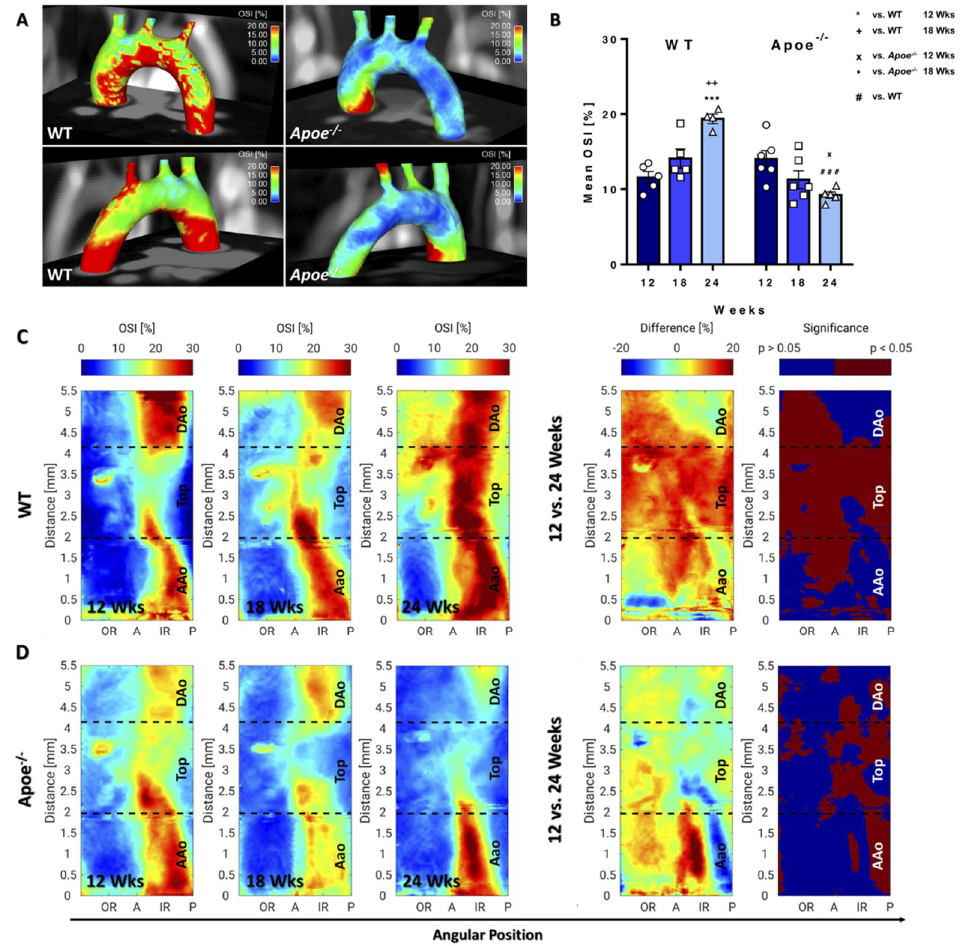
Figure 6. OSI decreases in Apoe − / − mice during atherosclerosis progression but increases in WT mice during ageing. ( A ) Three-dimensional OSI map of a 24-week-old WT mouse (left) and Apoe − / − mouse (right) from anterior and posterior view. The WT mouse showed high OSI values throughout the IR of the complete aorta, whereas in the Apoe − / − mouse, values were only elevated in the IR of the AAo (see red spot). ( B ) Mean OSI: Values significantly increased in WT and decreased in Apoe − / − mice. *** vs. WT 12 weeks, p < 0.001; ++ vs. WT 18 weeks, p < 0.01; x vs. Apoe − / − 12 weeks, p < 0.05; ### vs. WT, p < 0.001. ( C ) OSI maps of WT mice (group average) for all measurement time points and statistical intragroup comparison of OSI values (12 vs. 24 weeks), showing the difference maps of OSI values and significance maps. ( D ) OSI maps of Apoe − / − mice.